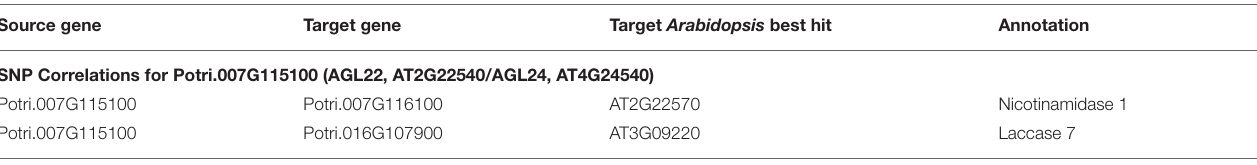
TABLE 4 | SNP correlation associations for select new potential target genes. Annotations are derived from best Arabidopsis hit descriptions, GO terms and in some cases MapMan annotations. Source gene Target gene Target Arabidopsis best hit